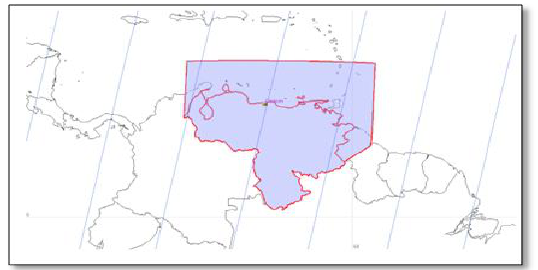
Figure 5. VRSS-2 Camera access capacity with ±29° roll maneuver in 4 days